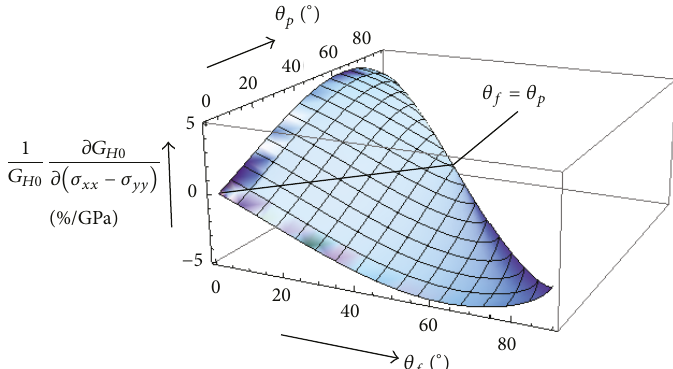
Figure 21: 𝜕𝐺 𝐻0 /𝜕(𝜎 𝑥𝑥 −𝜎 𝑦𝑦 )/𝐺 𝐻0 for circular Hall plates of Figure 10(a) versus contact sizes 𝜃 𝑓 and 𝜃 𝑝 . This is the piezoresistive influence on the current related magnetic sensitivity of the Hall plate. It vanishes for symmetric devices with 𝜃 𝑓 = 𝜃 𝑝 and it is strongest for devices, where one contact pair is point-sized and the other contact pair has a half-aperture angle of 62.5 ∘ . The plot assumes low n-doped (100)-silicon with 𝜋 = −0.136/ GPa. The plot region 89.5 ∘ < 𝜃 44 holds 𝐺 𝐻0 = 0 (see Figure 13) and 𝜕𝐺 𝐻0 /𝜕(𝜎 𝑥𝑥 − 𝜎 𝑦𝑦 )/𝐺 𝐻0 = 0 .